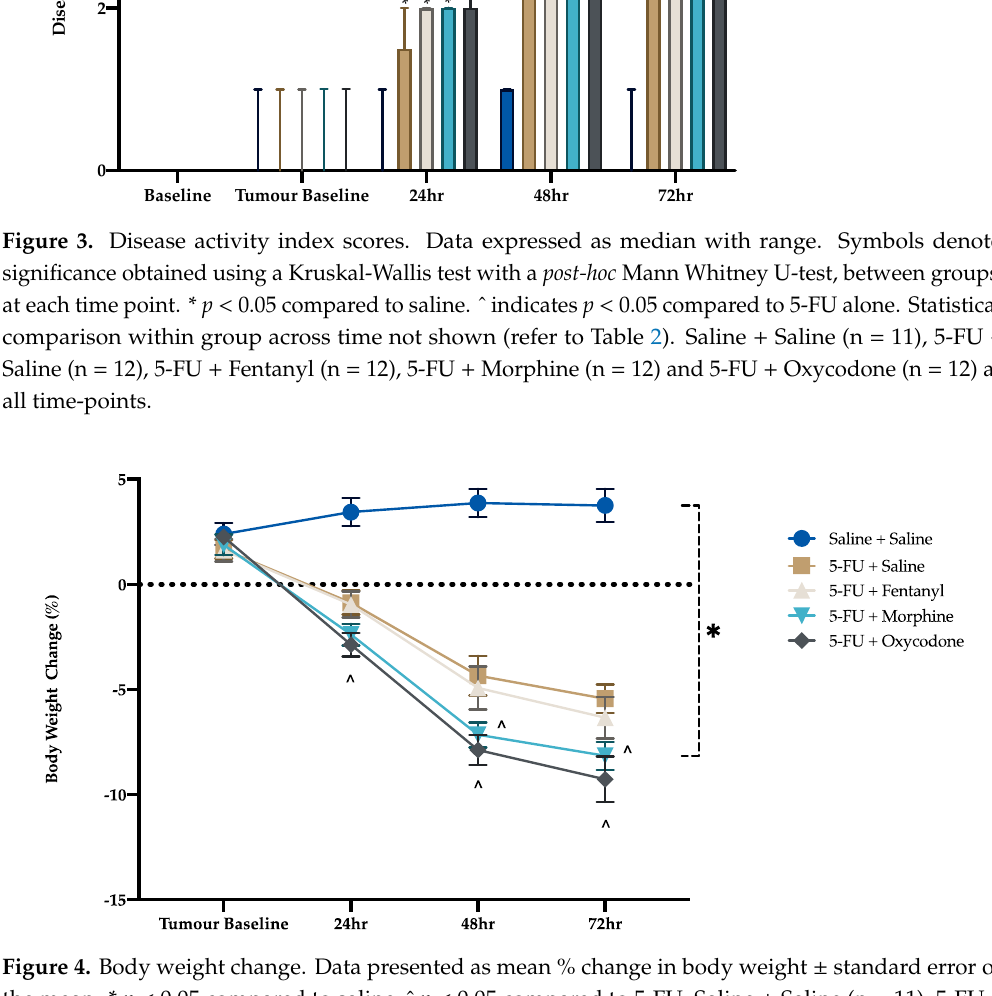
Figure 4. Body weight change. Data presented as mean % change in body weight ± standard error of the mean. * p < 0.05 compared to saline, ^ p < 0.05 compared to 5-FU. Saline + Saline (n = 11), 5-FU + Saline (n = 12), 5-FU + Fentanyl (n = 12), 5-FU + Morphine (n = 12) and 5-FU + Oxycodone (n = 12) at all time-points.